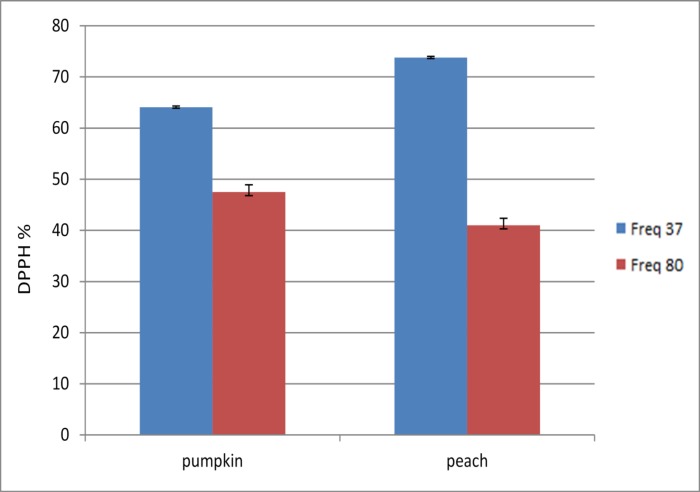
The effect of ultrasound frequency on % DPPH.